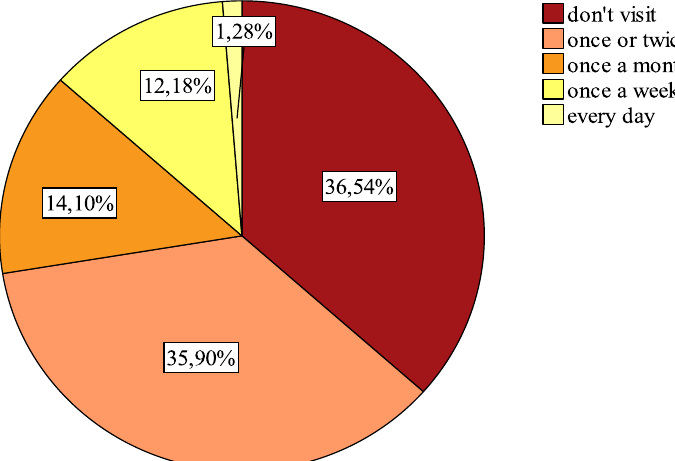
Fig. 5. Fequency of visits to natural protected areas in